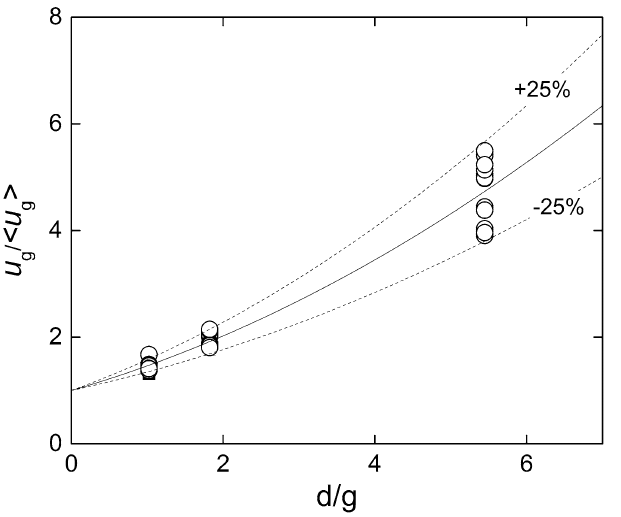
Figure 9. Ratio between the maximum u g and the average (cid:31) u g (cid:30) velocities at the central cross section of . the channel The solid and dashed curves corresponds to Eq. (5) and the bounds varying ± 25% of the corresponding coefficients. Created with Gnuplot 5.4, www. gnupl ot. info.